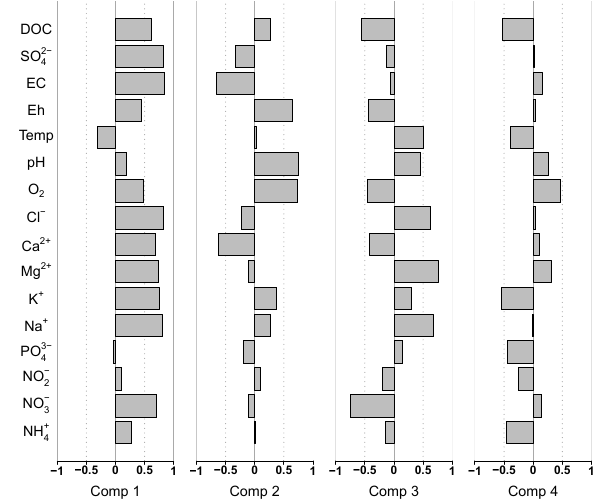
Figure 3. Spearman rank correlation of a component and the resid- uals of the multiple linear regression of the measured variable and the remaining three other